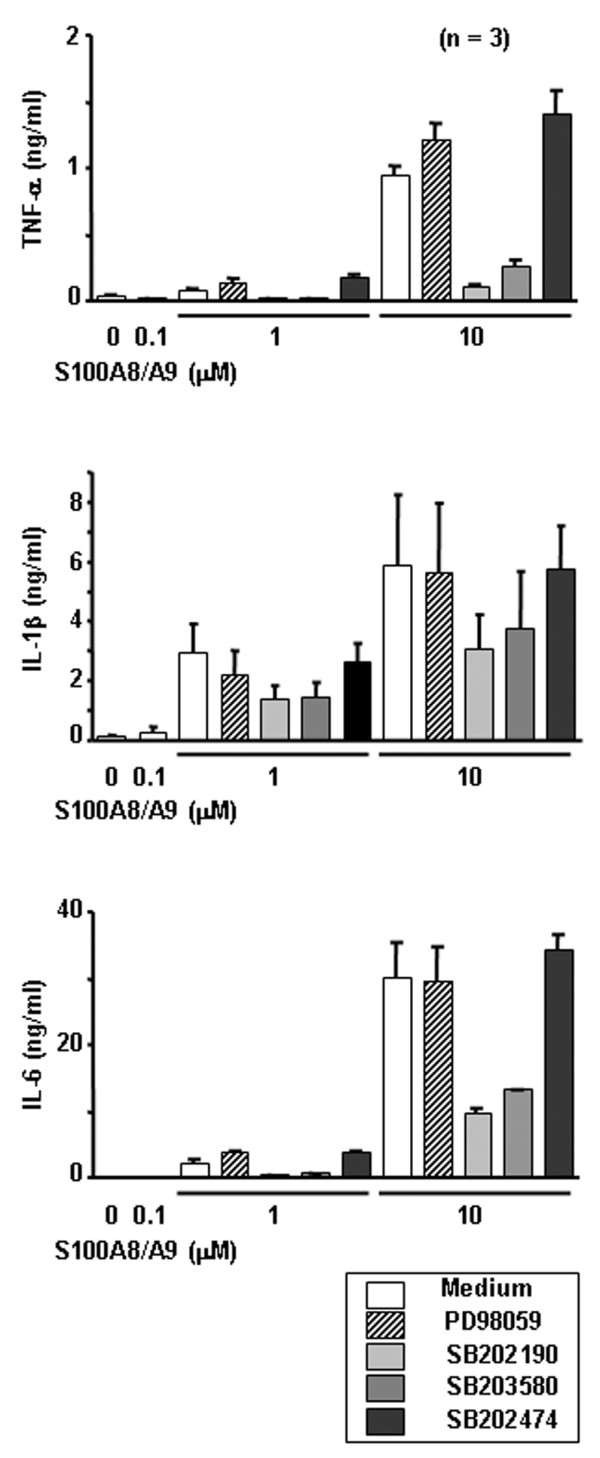
Effects of mitogen-activated protein kinase (MAPK) inhibitors on S100A8/A9-mediated cytokine production. Monocytes from healthy individuals (1 × 106 cells per ml in culture medium with 10% fetal calf serum) were preincubated for 2 hours in the presence of the MAPK inhibitors PD98059, SB202190, and SB203580 and the negative control SB202474 (1 μM) and were then stimulated for 24 hours with or without S100A8/A9 (0.1–10 μM) in the presence of polymyxin B (100 μg/ml). Culture supernatants were measured for cytokines by cytometric beads array. Values are the mean ± standard error of the mean. IL, interleukin; n, number of samples tested; TNF-α, tumor necrosis factor alpha.